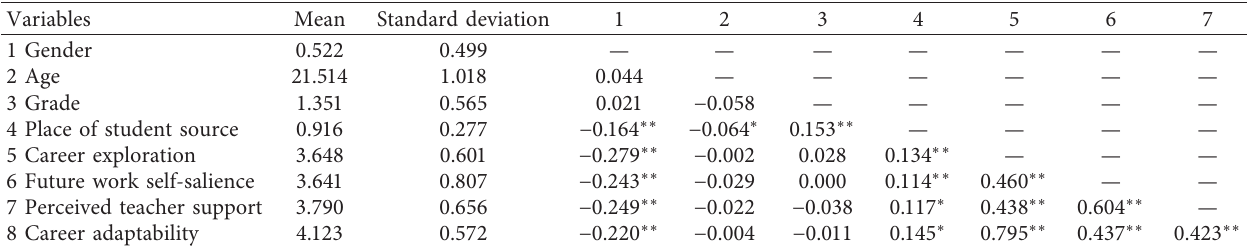
Table 2: Mean, standard deviations, and correlation coefficients of variables ( N � 1101).